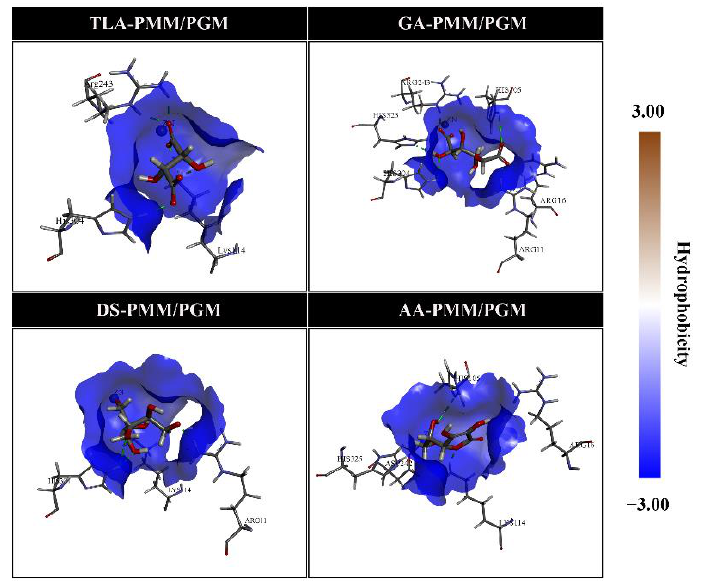
Figure 6. Hydrophobic pocket areas for molecular docking of phosphomannomutase/phosphoglucomutase by several ligands. Brown and blue indicate the hydrophobic and hydrophilic pocket areas, respectively.